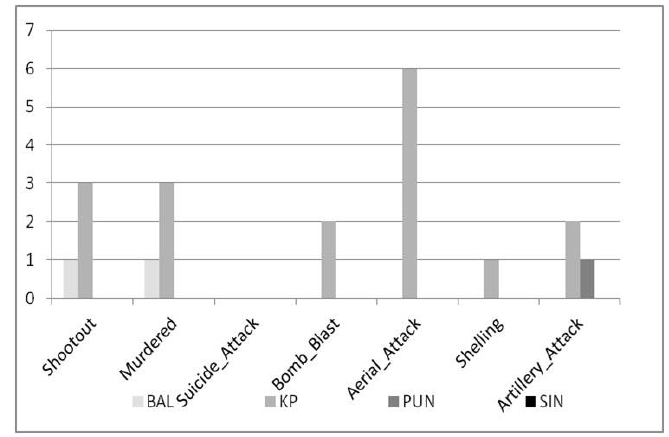
Figure 12. Number of clusters obtained for different Terror Attack – Method combinations.